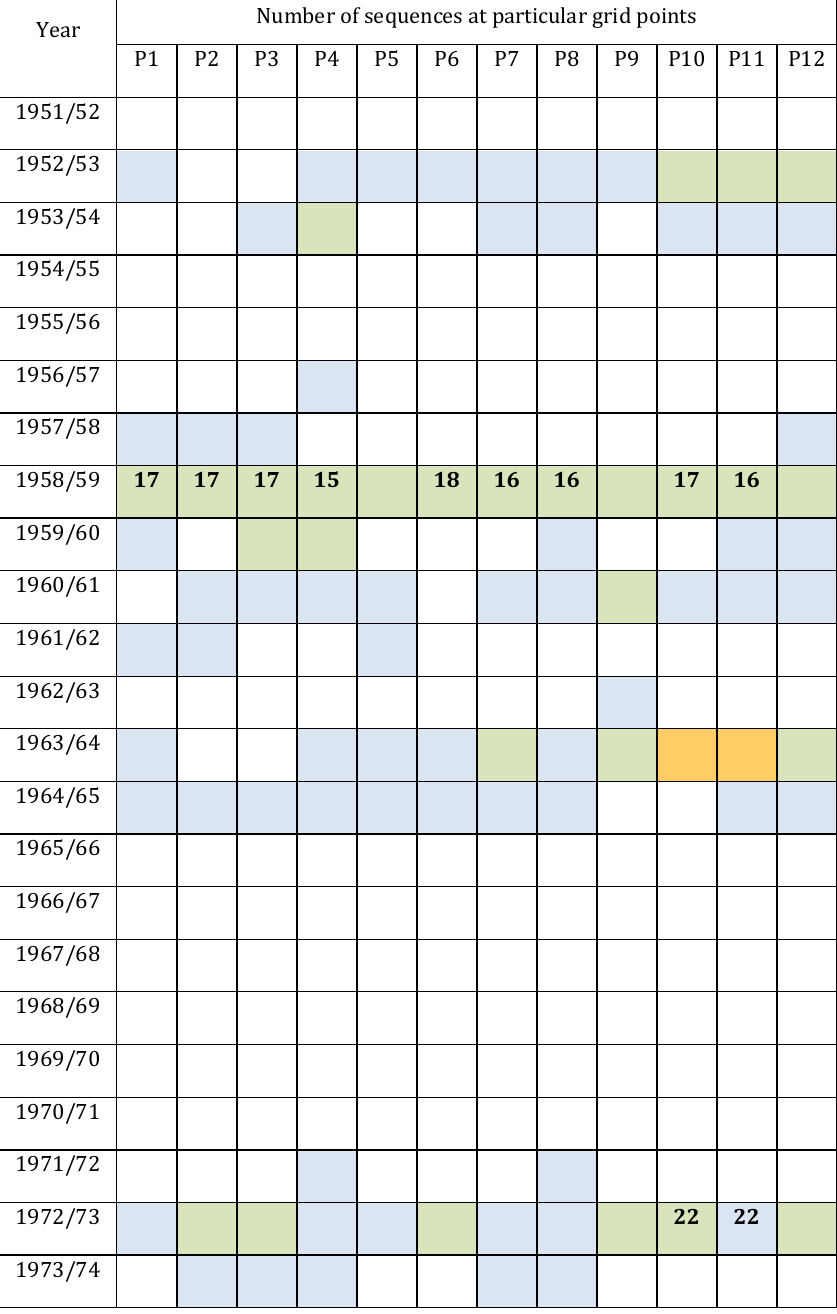
Table 7. Number of sequences of days with SHP lasting 6 or more days at particular grid points in the period 1951-2015 Number of sequences at particular grid points Year